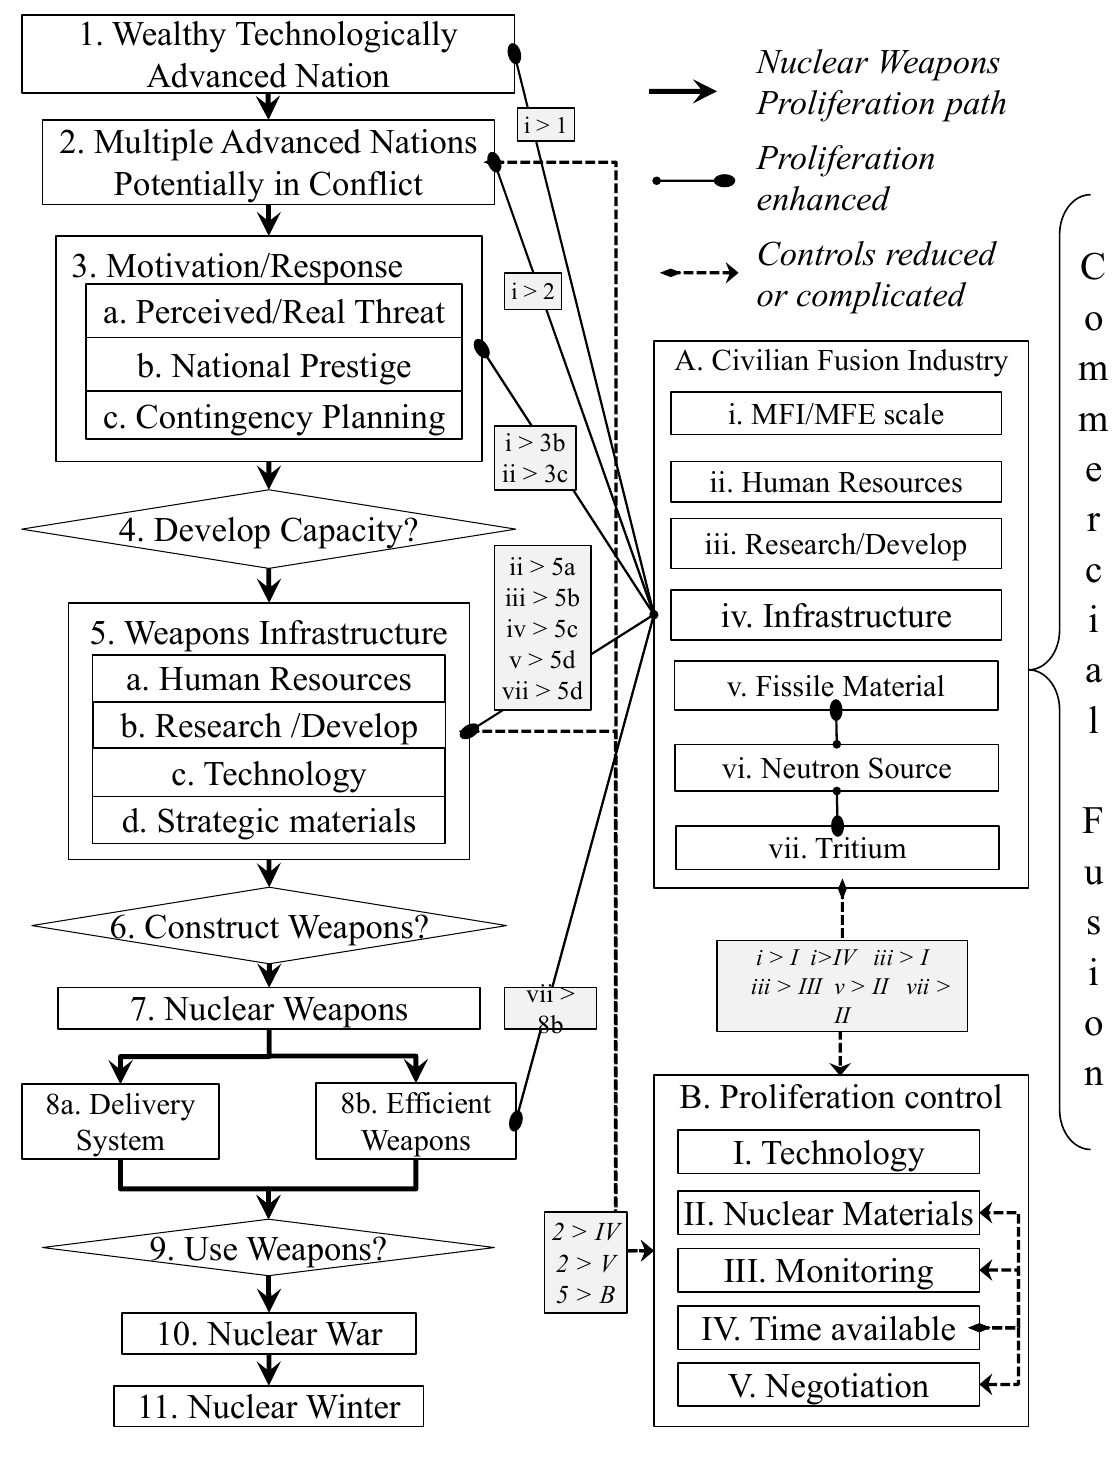
Figure 1. Proliferation risk pathway showing critical points where commercial fusion could increase the risk of a nuclear winter.